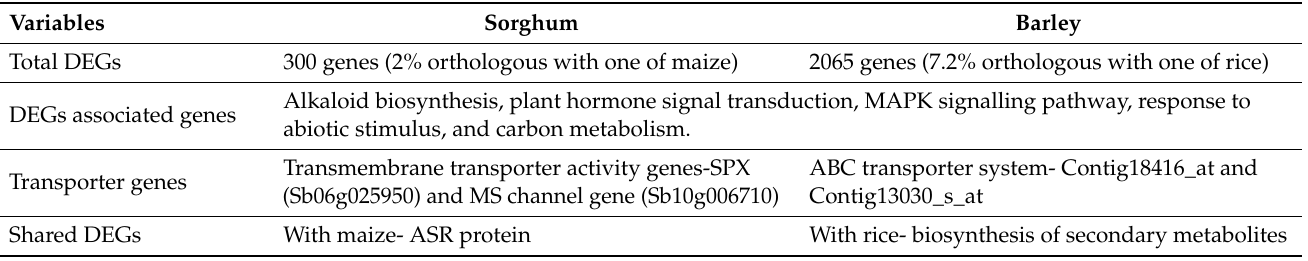
Table 3. Meta-analysis on the transcriptional response of Sorghum and Barley to drought stress, according to a study by Tahmasebi et al. [141].